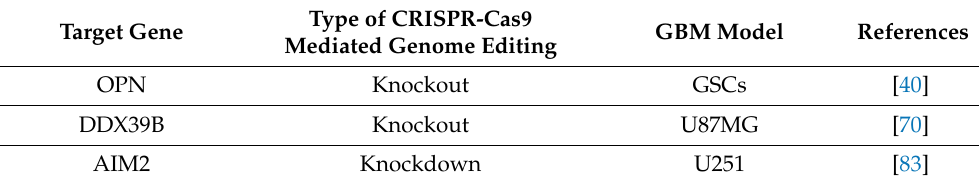
Table 6. CRISPR-Cas9 mediated knockouts of the inflammation genes in